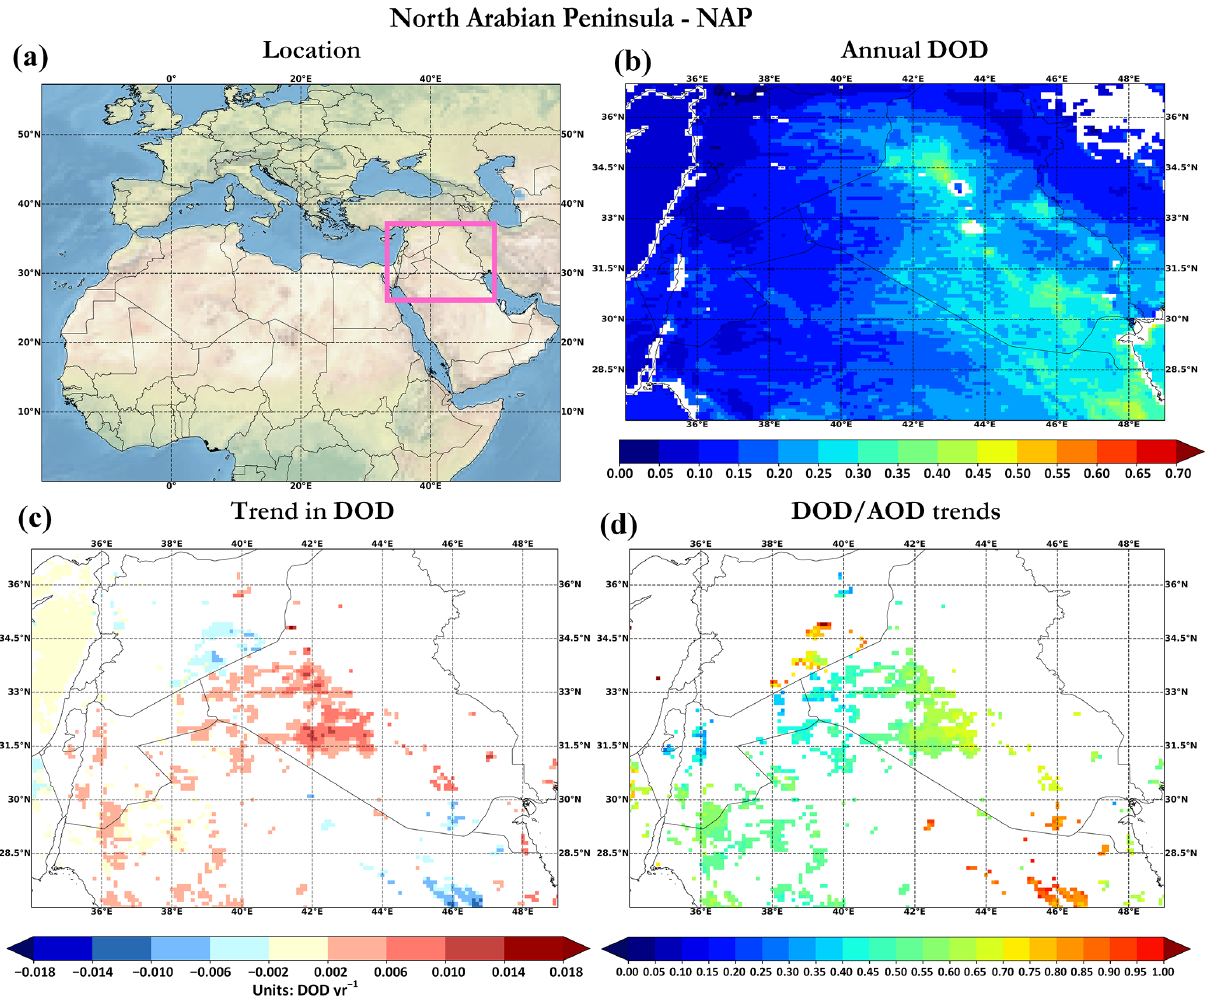
Figure 14. Same as Fig. 10, but for the northern Arabian